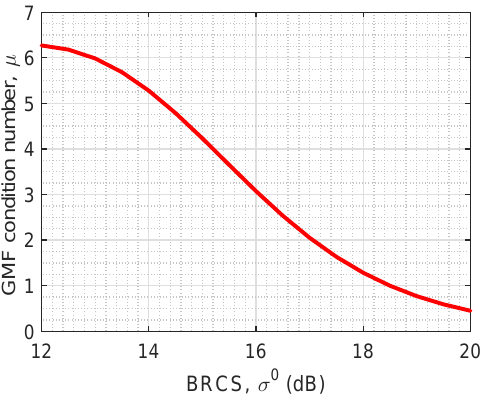
Figure 1. Condition number of a TechDemoSat-1 (TDS-1) wind speed Geophysical Model Function (GMF) converting the Bistatic Radar Cross Section (BRCS) to wind